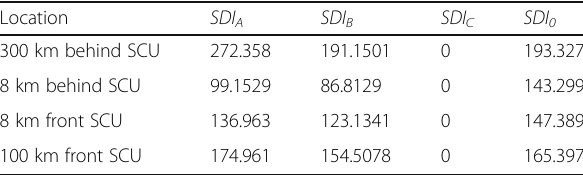
Table 7 SDI values during ABg faults with high resistance at the presence of series capacitors